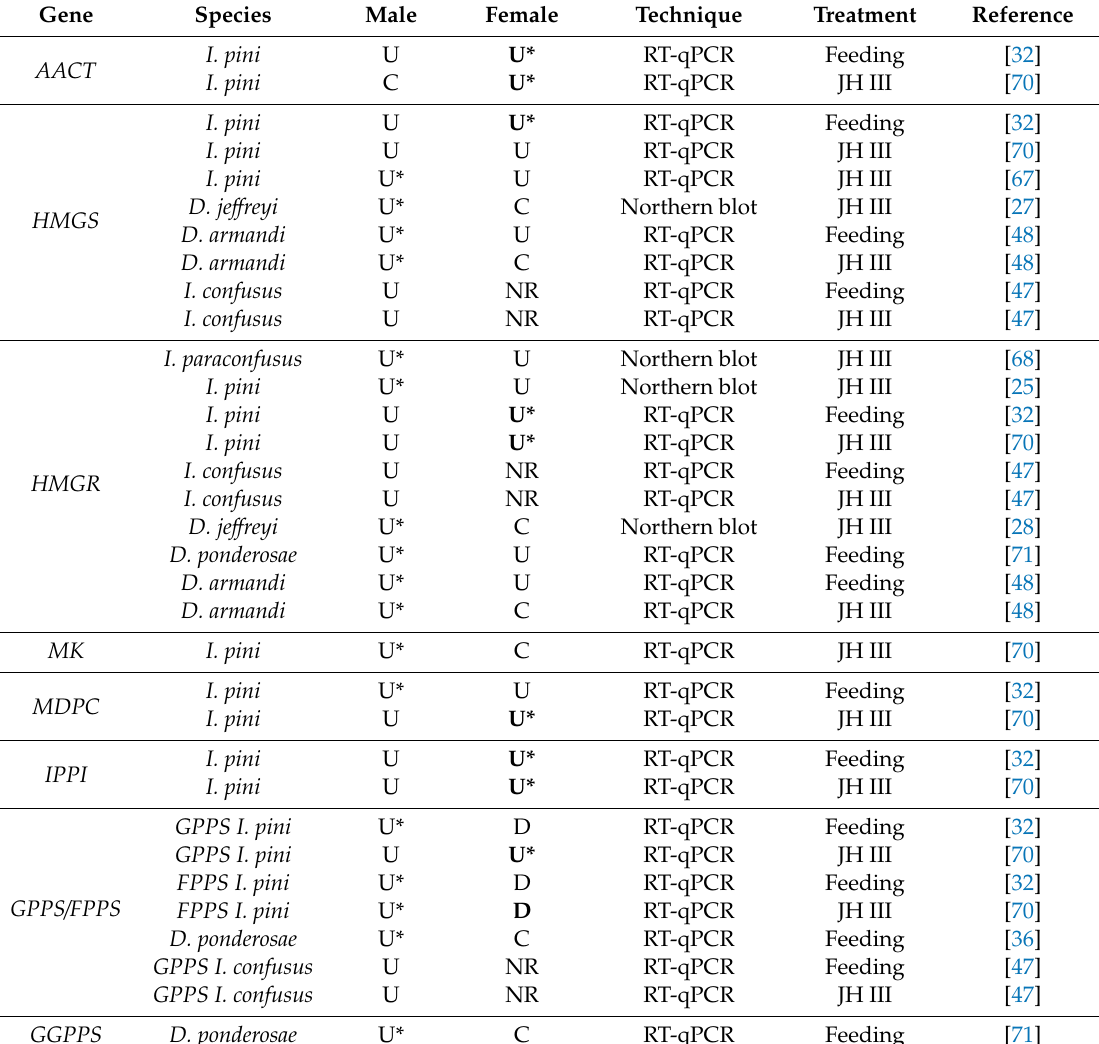
Table 4. Previous reports of relative expression analysis of bark beetle MVA pathway genes after feeding on phloem or JH III